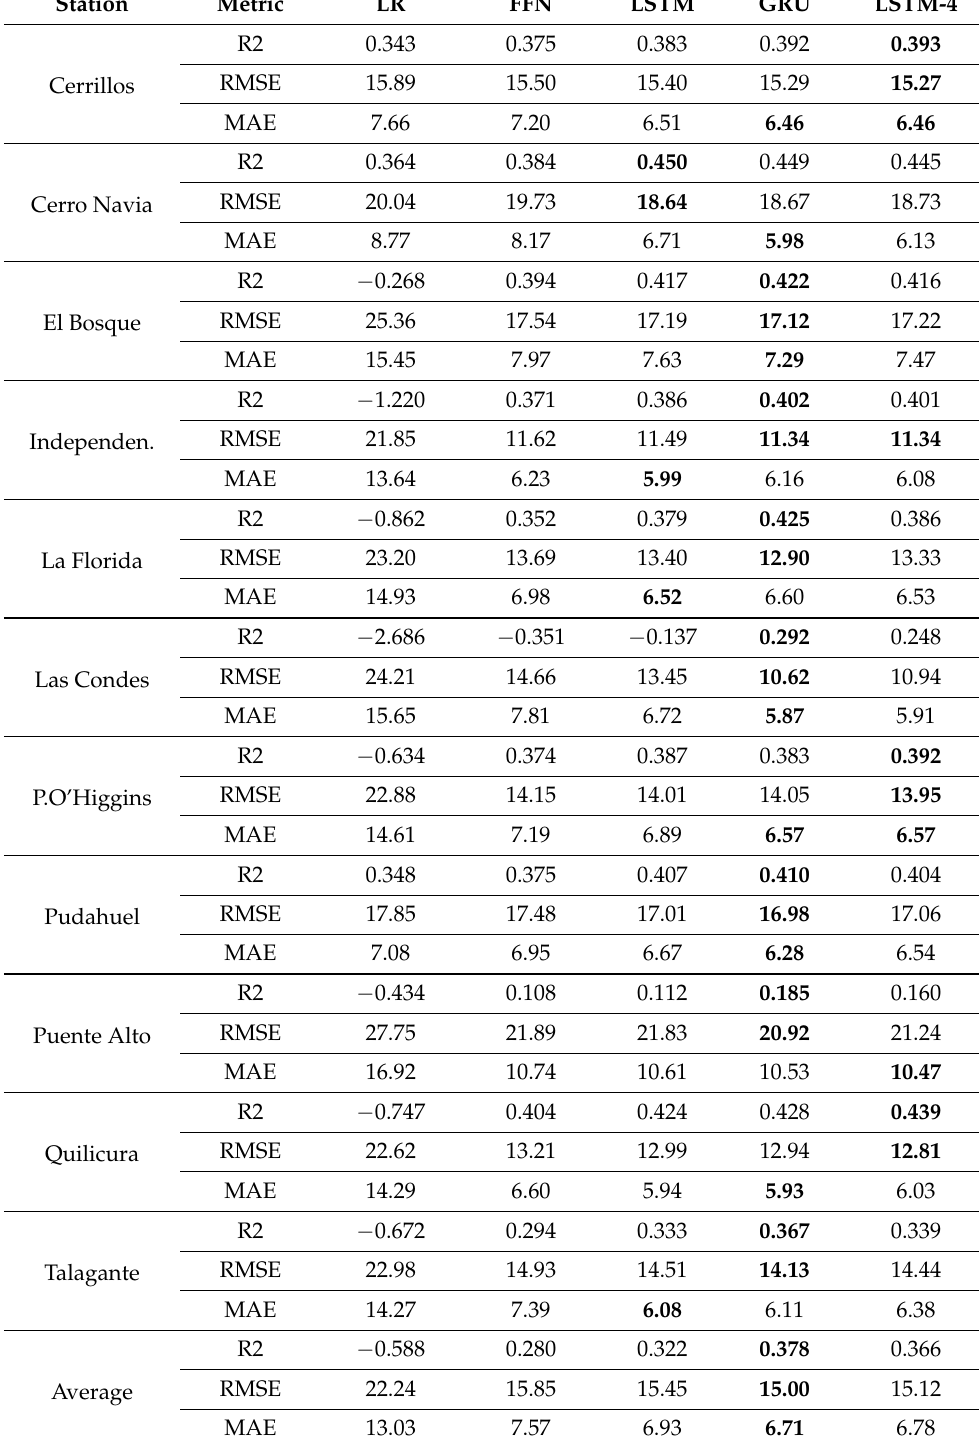
Table 10. Metrics of space-time prediction considering 11 stations, of 24 h in the future. Bold font indicates best